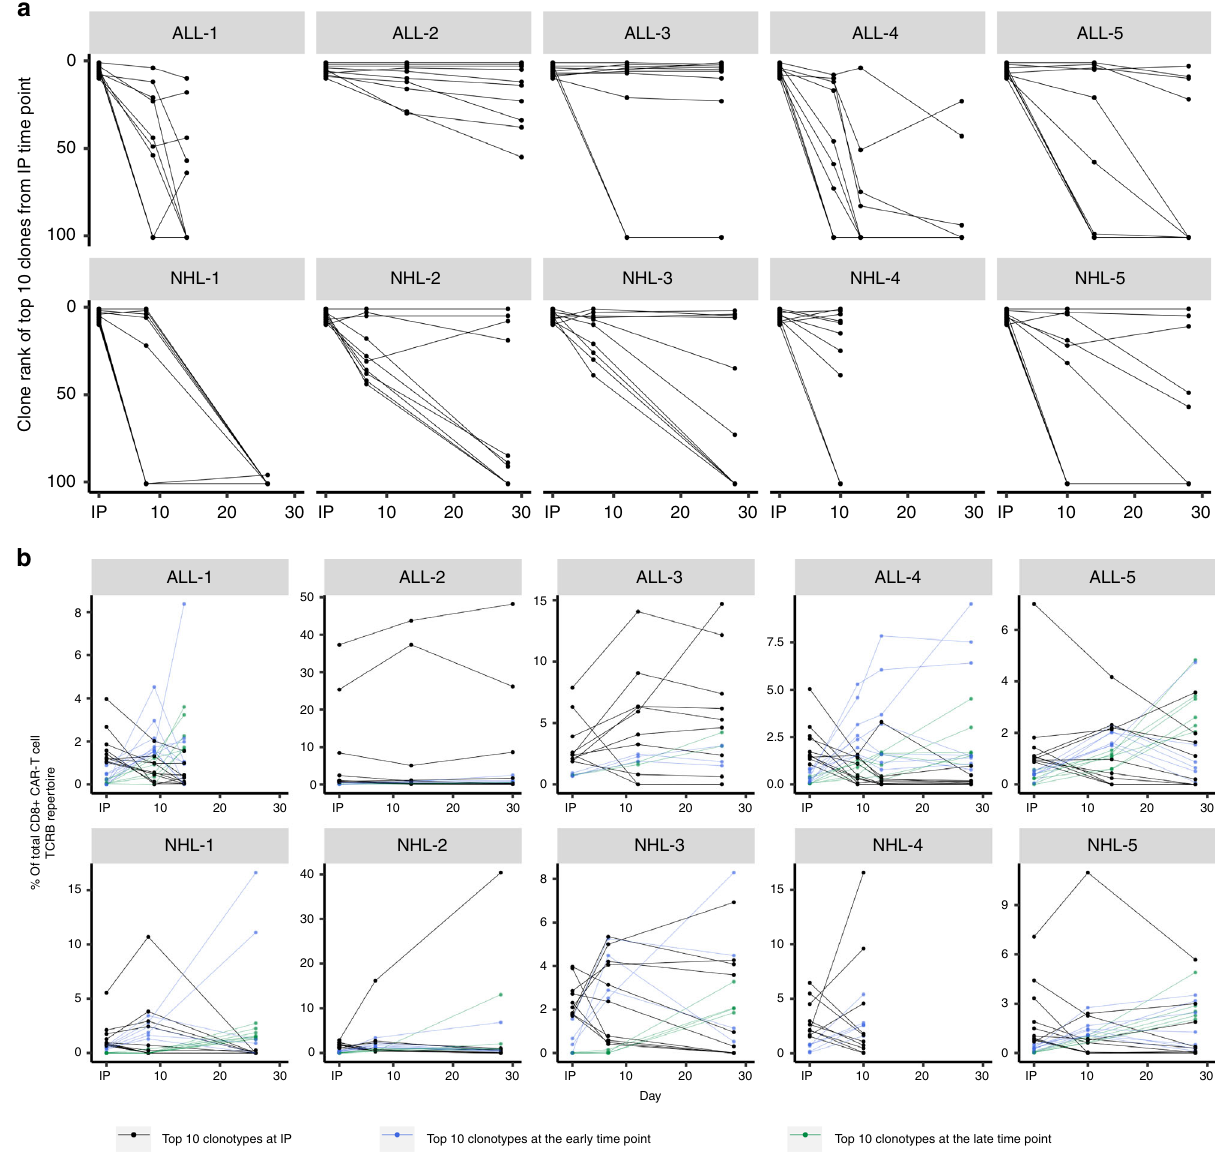
Fig. 2 Rank and relative frequency of the top ten clonotypes in the IP can change after infusion. a The rank of the top ten CD8 + CAR-T cell clonotypes in the IP were tracked over time and shown at the early and late time points. All rank positions >100 were designated in the fi gure as having a rank position of 101. Each line represents an individual clonotype. b The relative frequencies of the top ten ranked CD8 + CAR-T cell clonotypes from the IP (black line), the early (blue line), and late (green line) time points were followed over time. Each line represents an individual clonotype. Source data are provided as a Source Data fi